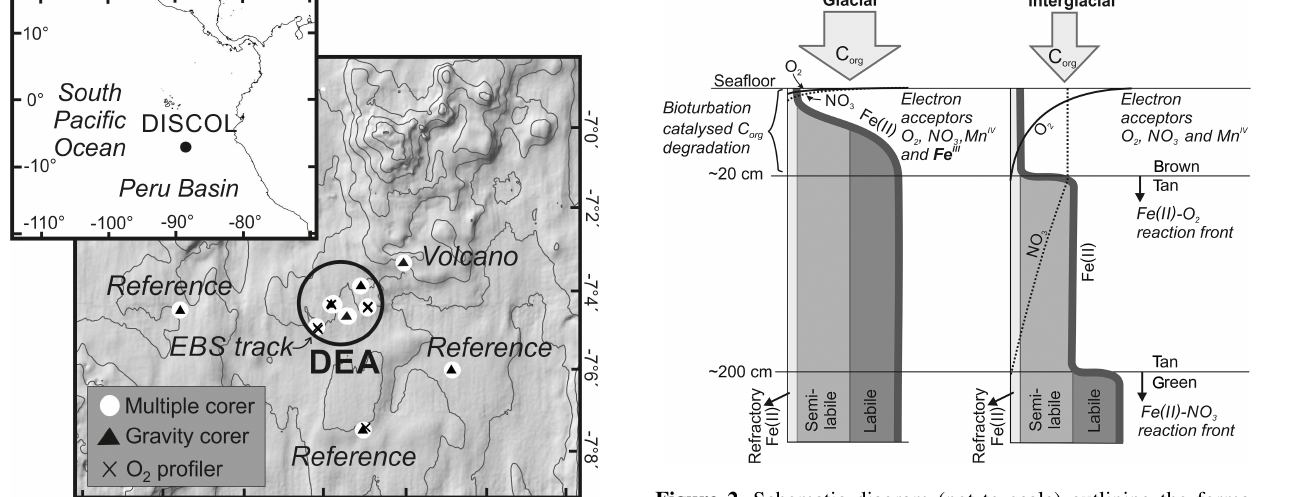
Figure 2. Schematic diagram (not to scale) outlining the forma- tion of a Fe(II)-rich clay phase (green) in the context of glacially high organic-matter input and its conversion to Fe(III) by downward progressing NO 3 fronts during interglacial periods triggered by re- duced organic-matter input as postulated by König et al. (2001). In this study, we propose that a second reaction front exists impeding the downward O 2 migration through a reaction with the semi-labile Fe(II)